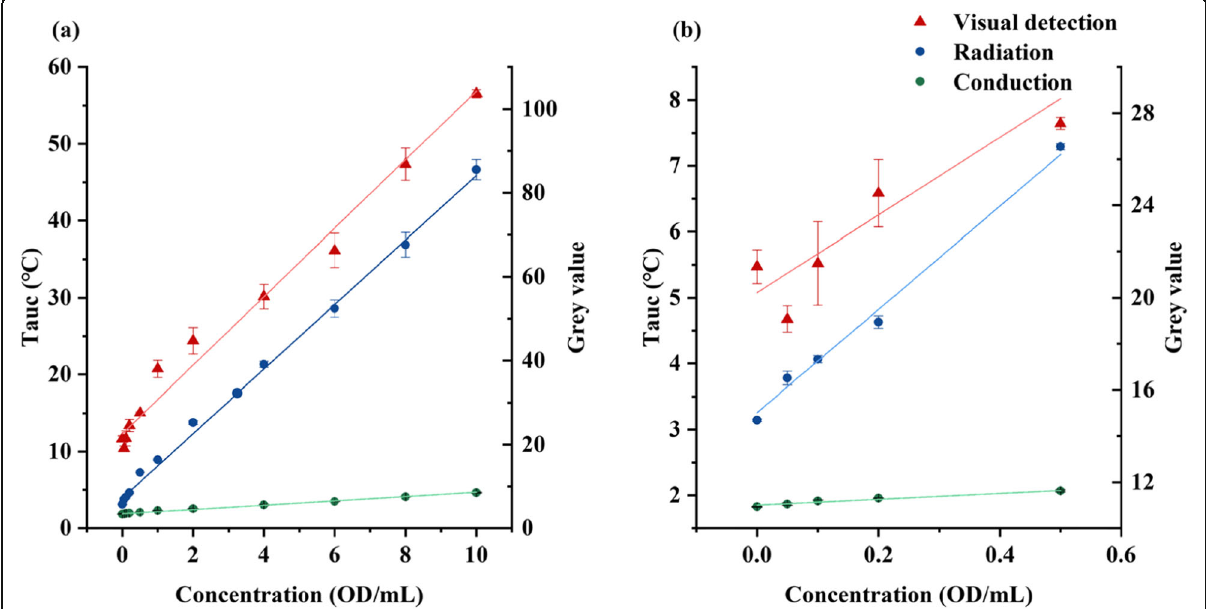
Fig. 5 Quantification of nanoparticle. a Standard quantification curves in three methods. b Quantitative results in low concentration with linear